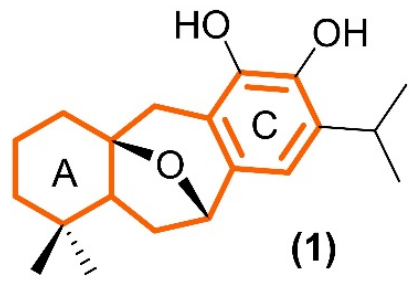
Figure 1. Molecular structure of brussonol ( 1 ). The structure in orange indicates the 6-7-6 tricyclic framework characteristic of icetexanes diterpenes.